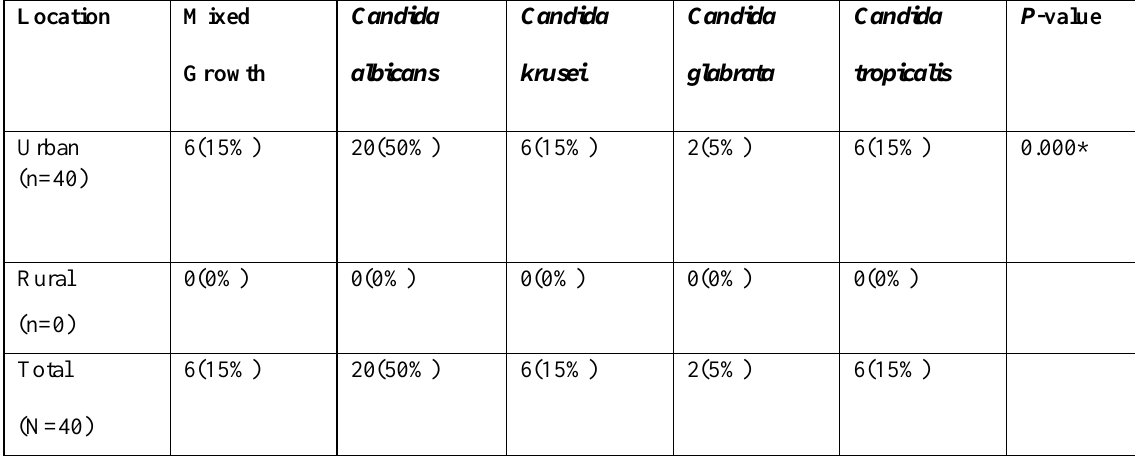
Table 6. Candida isolates in relationship with the area of residence of participants